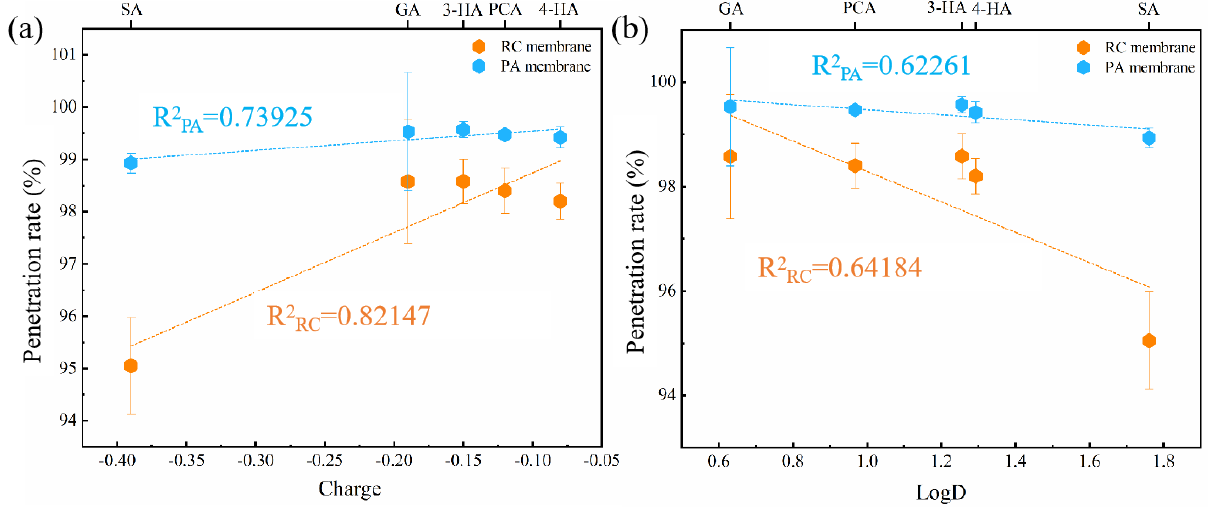
Figure 8. The correlations between the penetration rates of five phenolic acid compounds through the two membranes and two important physicochemical properties (( a ), for charge ,( b ), for logD values) of phenolic acids. Experimental conditions: 2 bar; feed concentration = 10 mM and 25 ± 2 °C.